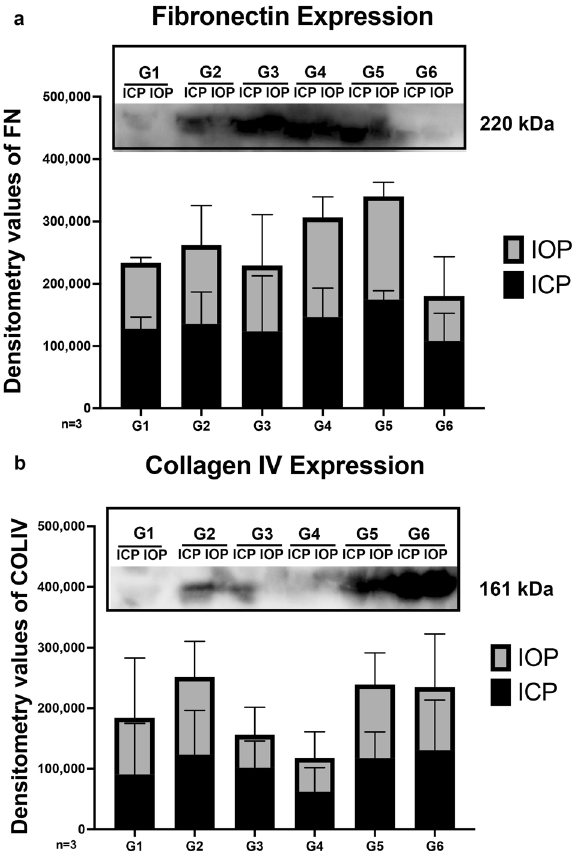
Fig. 4 Extracellular matrix secretion observed in ICP and IOP chamber conditioned medium of experimental groups. Condi- tioned medium collected from the IOP and ICP chambers of every group throughout 14-day perfusion culture. Densitometric values normalized to control after Western blot analysis was evaluated for expression of ( a ) FN and ( b ) COLIV. ICP intracranial pressure, IOP intraocular pressure, G1 group 1, G2 group 2, G3 group 3, G4 group 4, G5 group 5, G6 group 6, N = 3. Data are presented as mean ± standard error of the mean and P < 0.05 was considered statistically signi fi